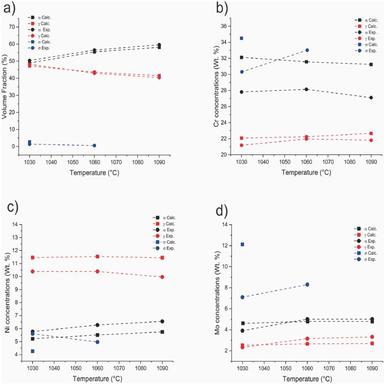
Phase fraction and elemental contribution obtained by CALPHAD simulation and experimental results, a) Volumetric fraction of phases present in heattreated SDSS-Nb; b) Cr concentration in the different phases of heat-treated SDSS-Nb; c) Ni concentration in the different phases of heat-treated SDSS-Nb; d) Mo concentration in the different phases of heat-treated SDSS-Nb.